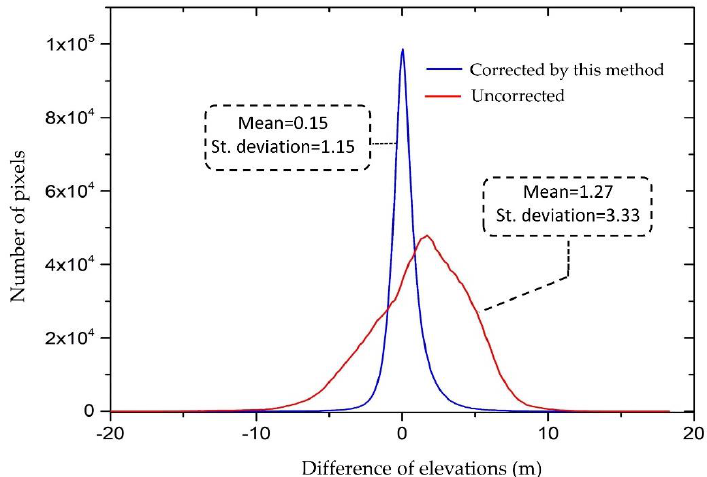
Figure 12. Comparison of histograms of the corrected and uncorrected DoD.